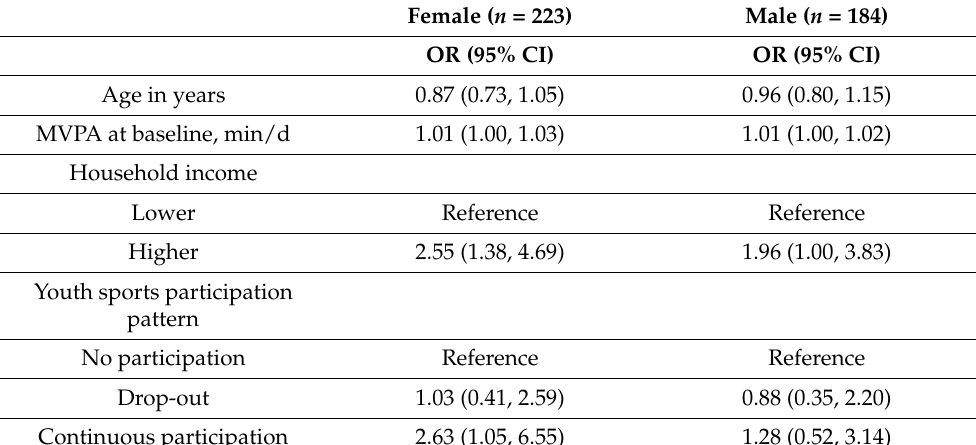
Table 3. Multivariable logistic regression models for meeting the aerobic Physical Activity Guidelines in